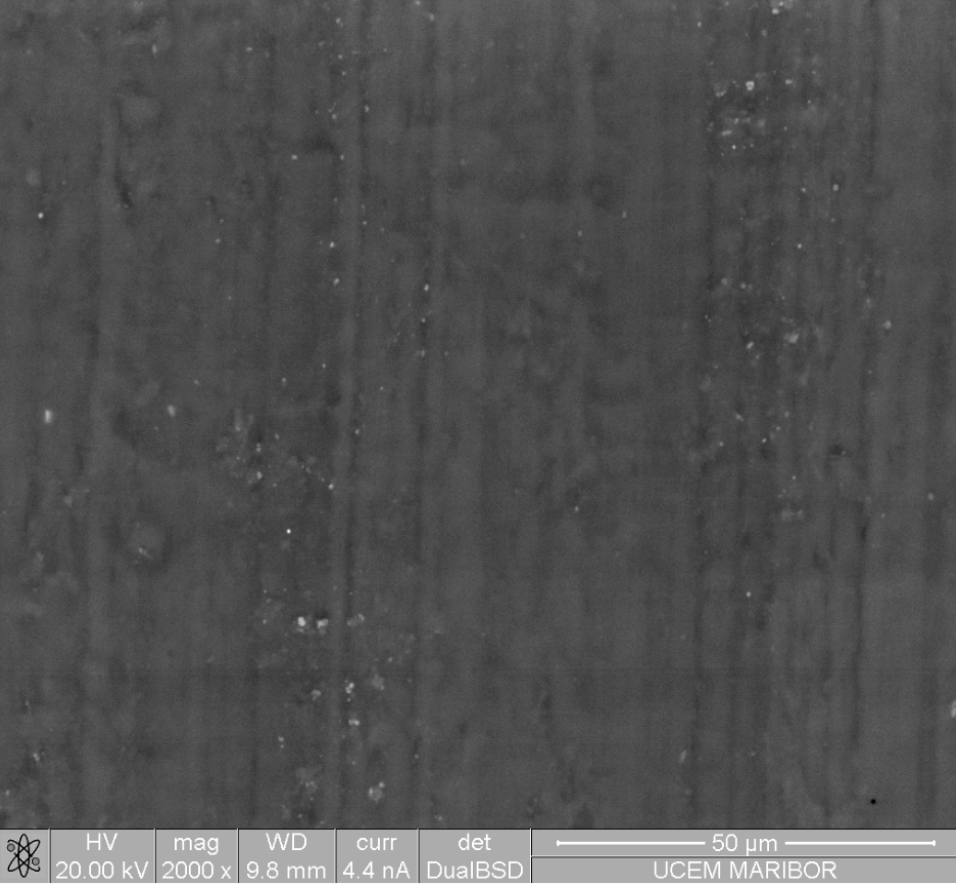
Figure 1. The backscattered electron micrographs of the hobbed gear made of POM.